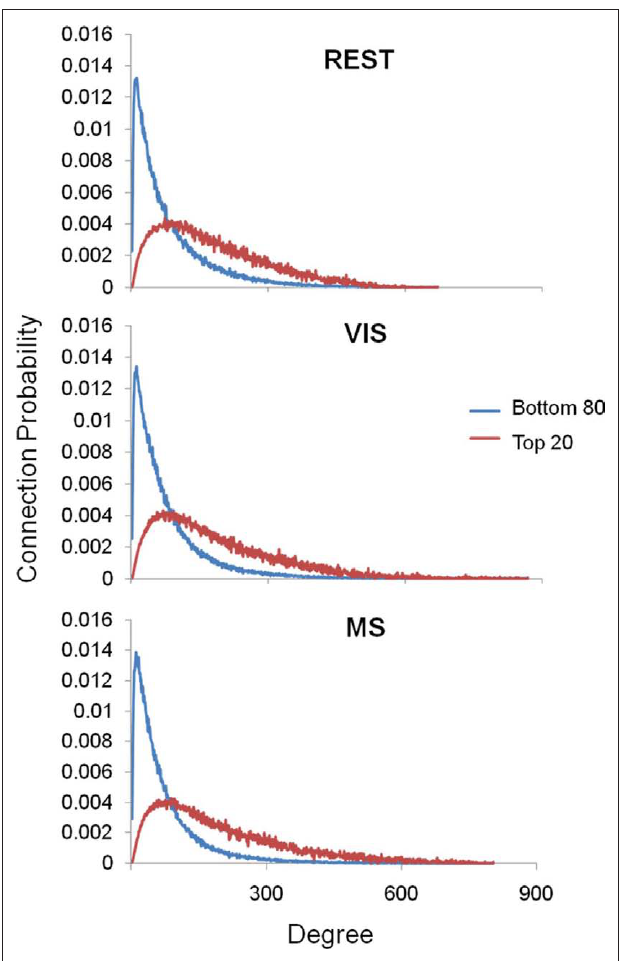
) for a jk Figure 3 | Assortativity sorted by degree. Above are the connection probabilities of the 80% lowest degree nodes and the top 20% highest degree nodes. For all three conditions rest (REST), visual (VIS), and multisensory (MS), the positive network assortativity was heavily weighted by low degree nodes. In each case, low degree nodes were connected with low degree nodes, peaking at nodes with a degree of around 25. On the other hand, high degree nodes’ connections were dispersed with a broad range of other degree